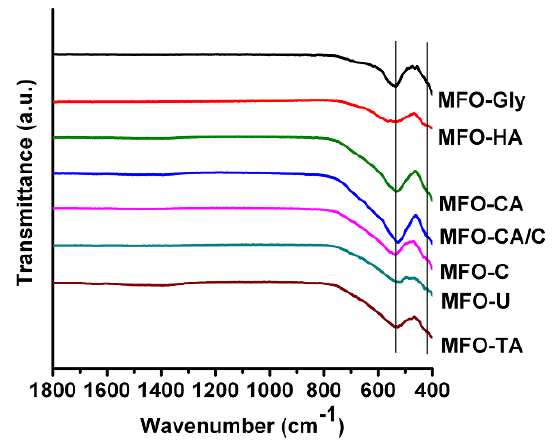
Figure 3. IR spectra of magnesium ferrite powder heat treated at 773 K.